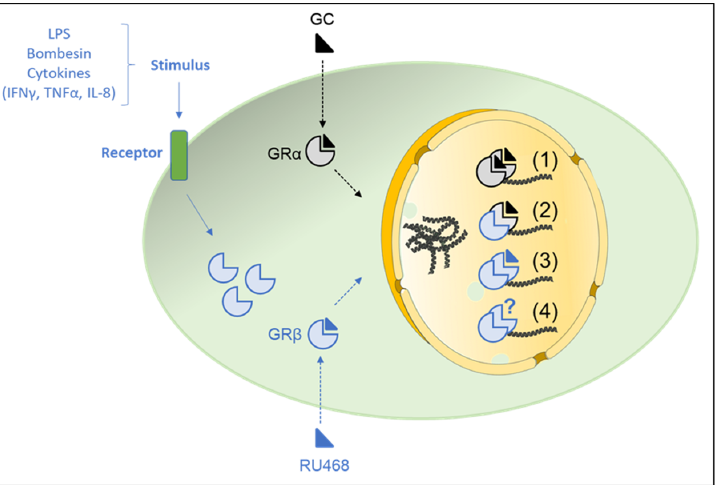
Figure 3. Possible mechanisms of action for GR β . The GC function is mediated by GR α or GR β . Different pro-inflammatory stimuli, such as TNF α , IFN γ , IL-8, or LPS, induce GR β expression. GR β is localized both in the cytoplasm and nucleus in a cell-type-specific manner. ( 1 ) Classic GC genomic effects mediated by GR α : Upon binding to GCs, GR α translocates into the nucleus where GR α homodimers bind to GREs to increase or decrease gene transcription. ( 2 ) GR β dominant-negative activity on GR α : GR β can translocate into the nucleus in a ligand-independent manner to either compete for GRE binding via their shared DBD or form inactive heterodimers with GR α . ( 3 ) GR β binds RU486 to control gene expression: The synthetic GC antagonist RU486 might bind to GR β and induce its nuclear translocation, where it modulates transcriptional activity independently of GR α . ( 4 ) Intrinsic activity of GR β (unknown ligand): GR β directly modulates the expression of a large number of genes independently of GR α . Hypothetical endogenous steroids might be involved in the nuclear translocation and the intrinsic activities of GR β . Parts of the figure were created using templates from Servier Medical Art, which are licensed under a Creative Commons Attribution 3.0 Unported License (http://smart.servier.com/). Last accessed on 20 January